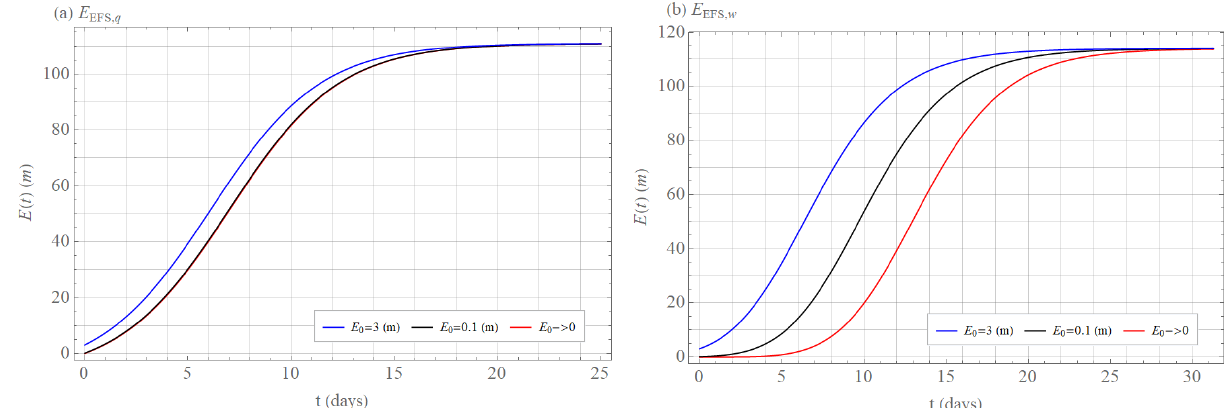
Figure 9. (a) The solution of the extended quadratic model E q (t) with parameters α EFS = 0.35d − 1 and β EFS = 2.8md − 1 , limit (saturated) = 111m and with initial errors E = 3m (blue), E = 0.1m (black), and E → 0 (red). (b) The solution of the extended value E EFS , ∞ 0 0 0 q = 114m and with initial power law E w (t) with the coefficient a EFS = 0.93m σ d − 1 , exponent σ EFS = 0.21, limit (saturated) value E EFS , ∞ q errors E 0 = 3m (blue), E 0 = 0.1m (black), and E 0 → 0 (red). Bar above parameters and limit value means averages over approximations of λ q (E) and λ w (E) from annual averages of the error growth rate λ EFS (E) of the ECMWF forecasting system’s 500hPa geopotential height values (Northern Hemisphere, 20–90 ◦ ) calculated as differences between two operational forecasts issued with 1d lag but valid on the same day.